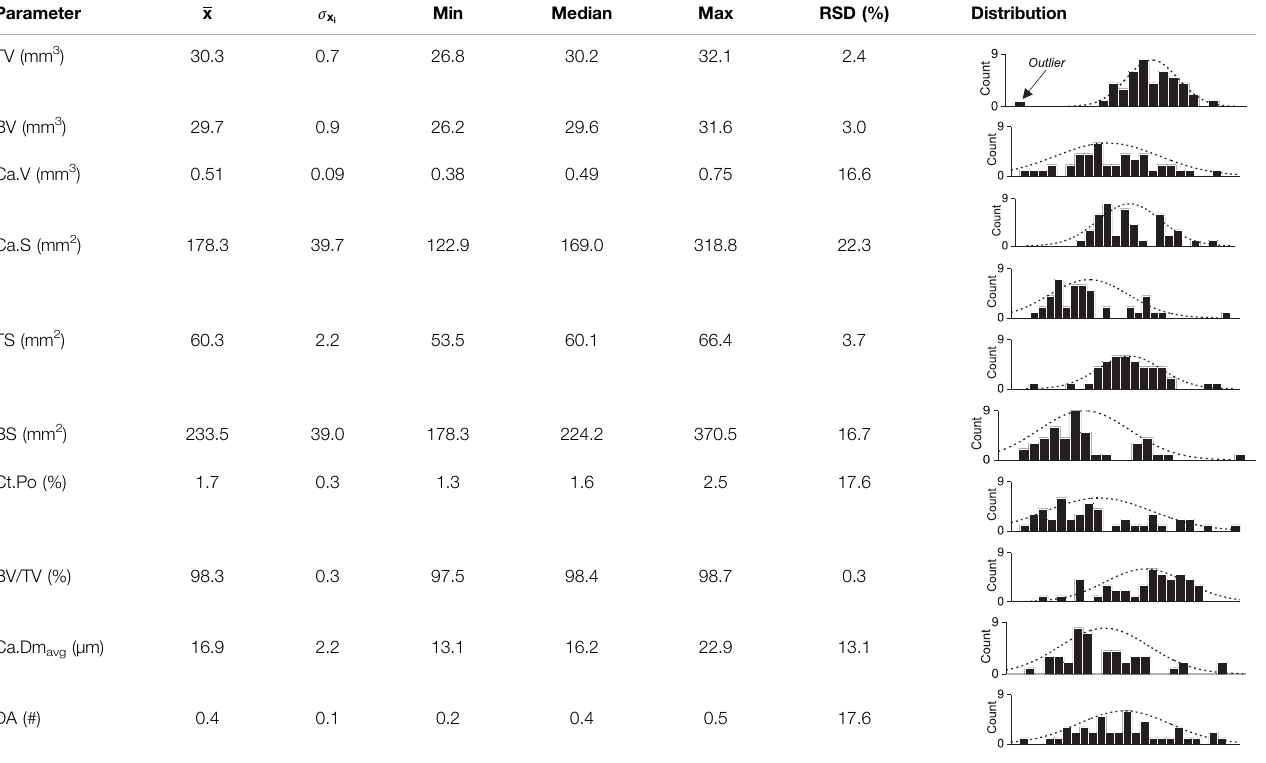
TABLE 4 | Statistical evaluation of the natural variation of bone parameters from 45 pristine cortical bone samples. Parameter